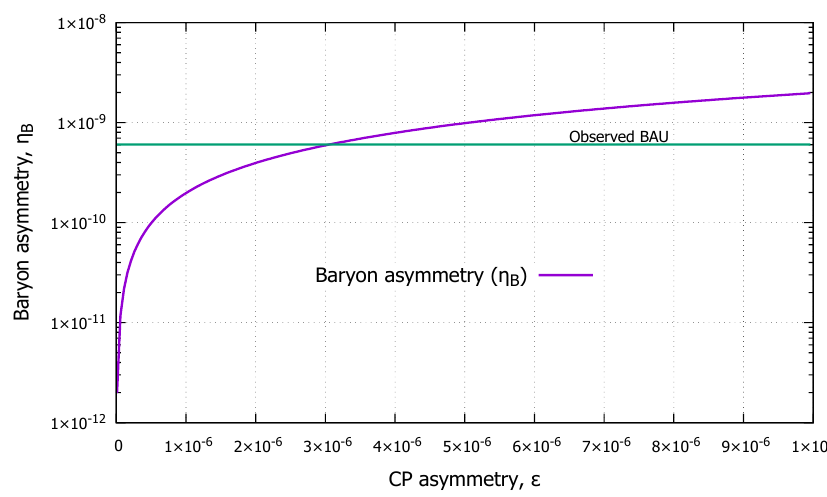
Figure 4 . The dependence of the baryon asymmetry on the CP asymmetry. In this (cid:12)gure, we keep Y N = 10 (cid:0) 4 : 5 ; (cid:21) N = 0 : 9 ; M = 10 4 GeV ; v S = 10 6 : 5 GeV ; variation in " is brought on by not (cid:12)xing A (cid:21) ; (cid:20); (cid:14) . We also take equilibrium initial condition for ~ N abundance. Starting with zero initial equilibrium for ~ N does not change the